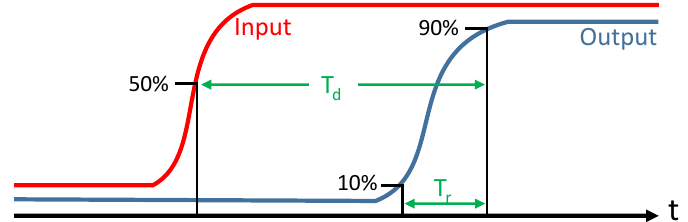
Figure 13. Definition of the rise time T r and delay T d .